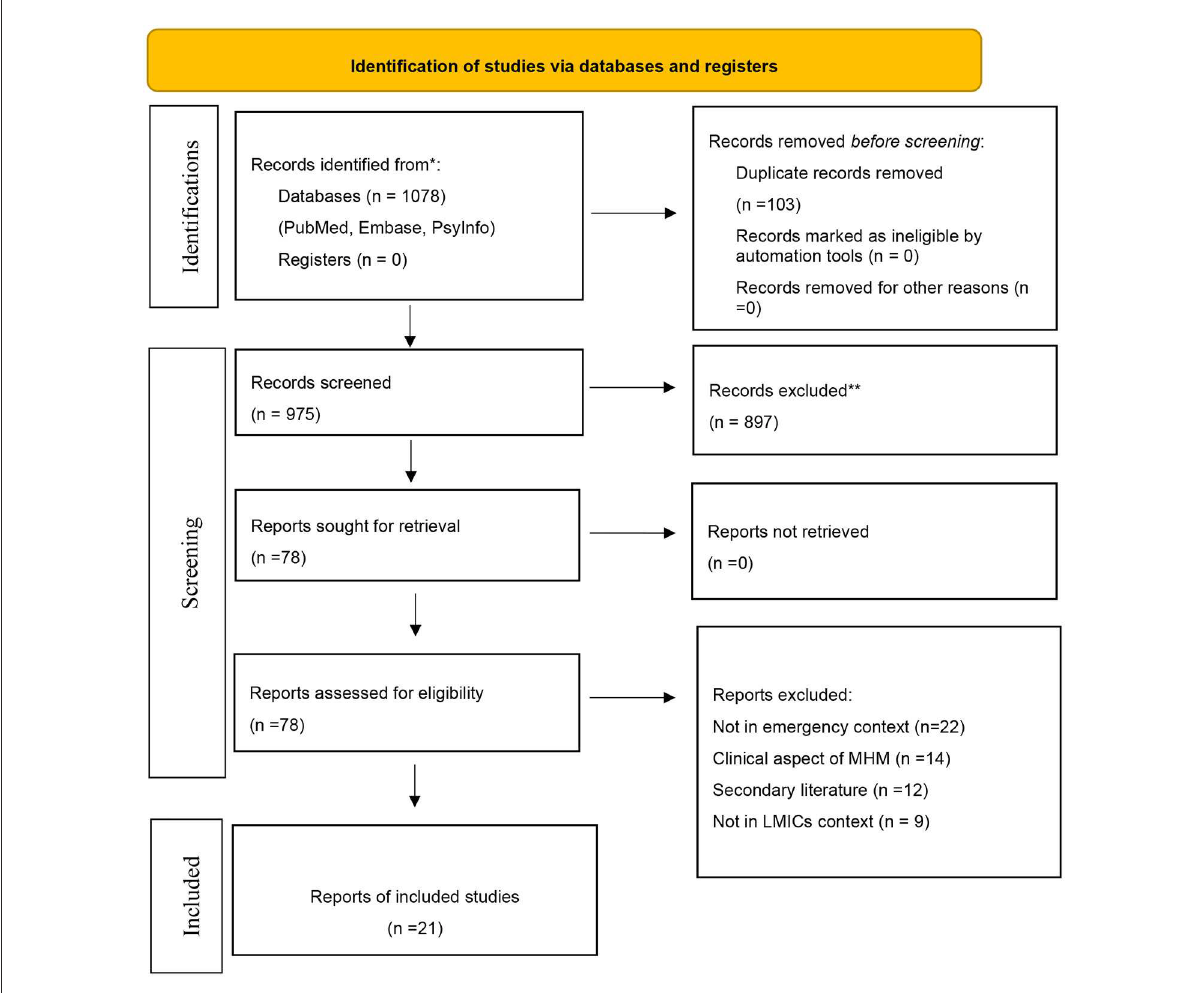
FIGURE1 PRISMA flow diagram.